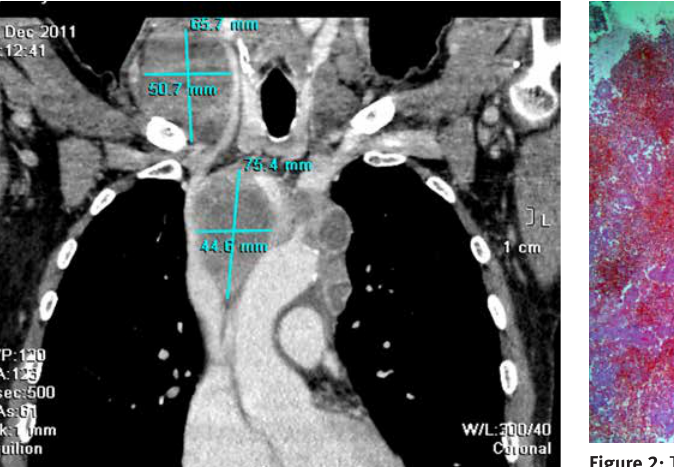
Figure 1: Neck and thorax computed tomography